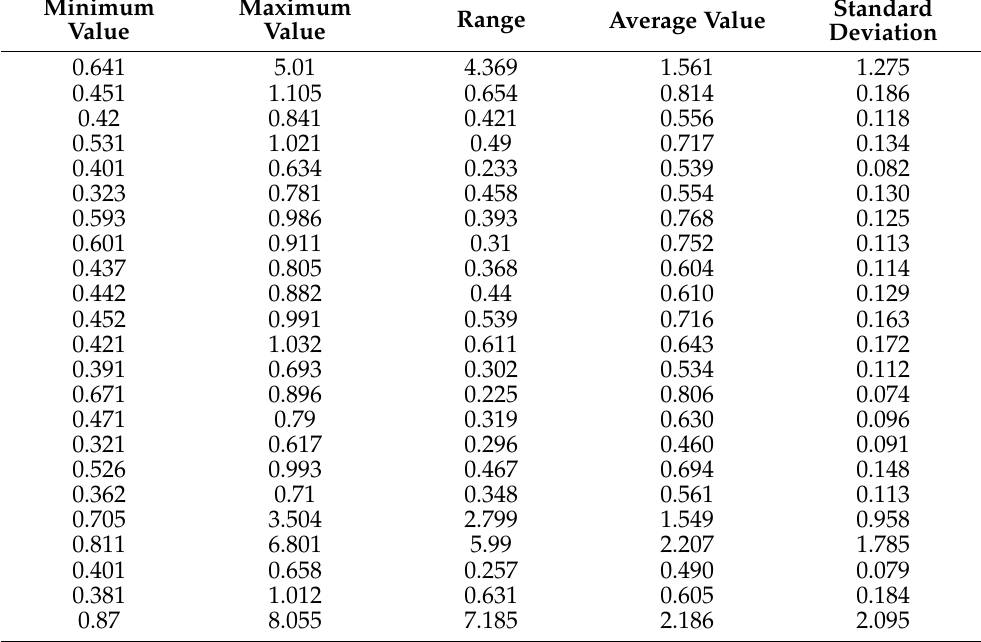
Table 6. Statistical parameters describing the differences between form deviations in subsequent cross-sections of each sphere from the first dataset (all values are given in micrometers).